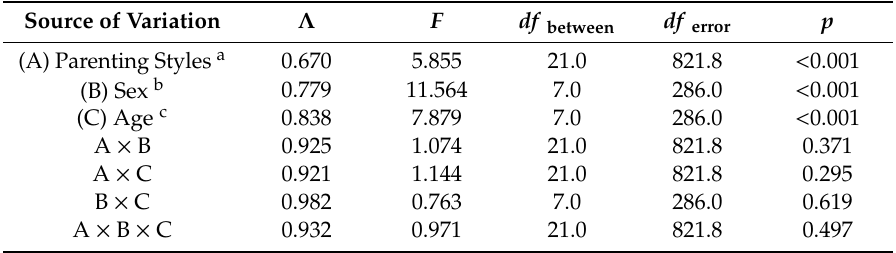
Table 2. Factorial MANOVA (4 a × 2 b × 3 c ) of self-concept, self-esteem, and ecological socialization. Source of Variation Λ F df between df error p